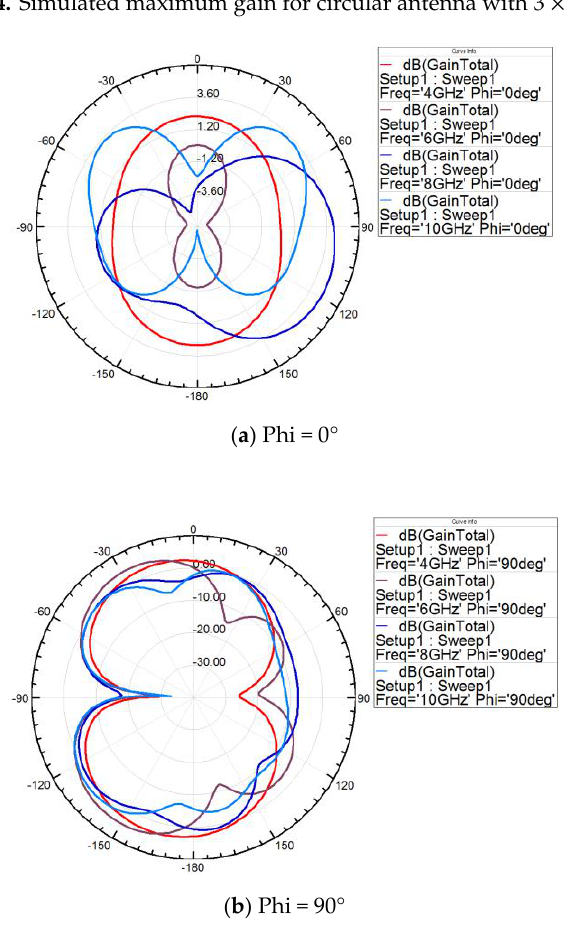
Figure 25. ( a ) Radiation pattern at Phi = 0 ◦ ( b ) radiation pattern at Phi = 90 ◦